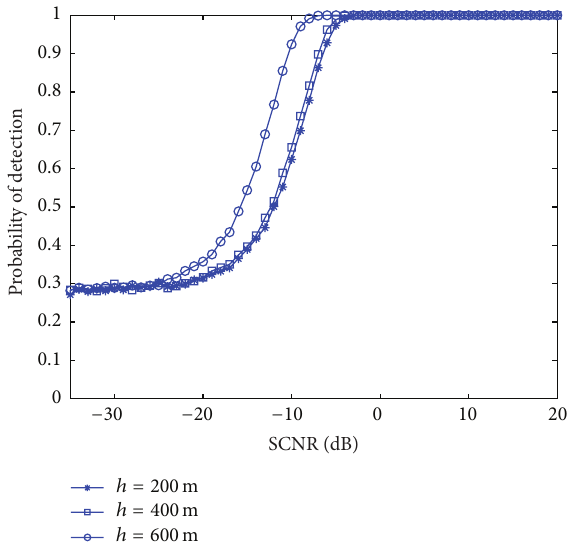
Figure 9: GLRT detector detection performance varies with the height of target.